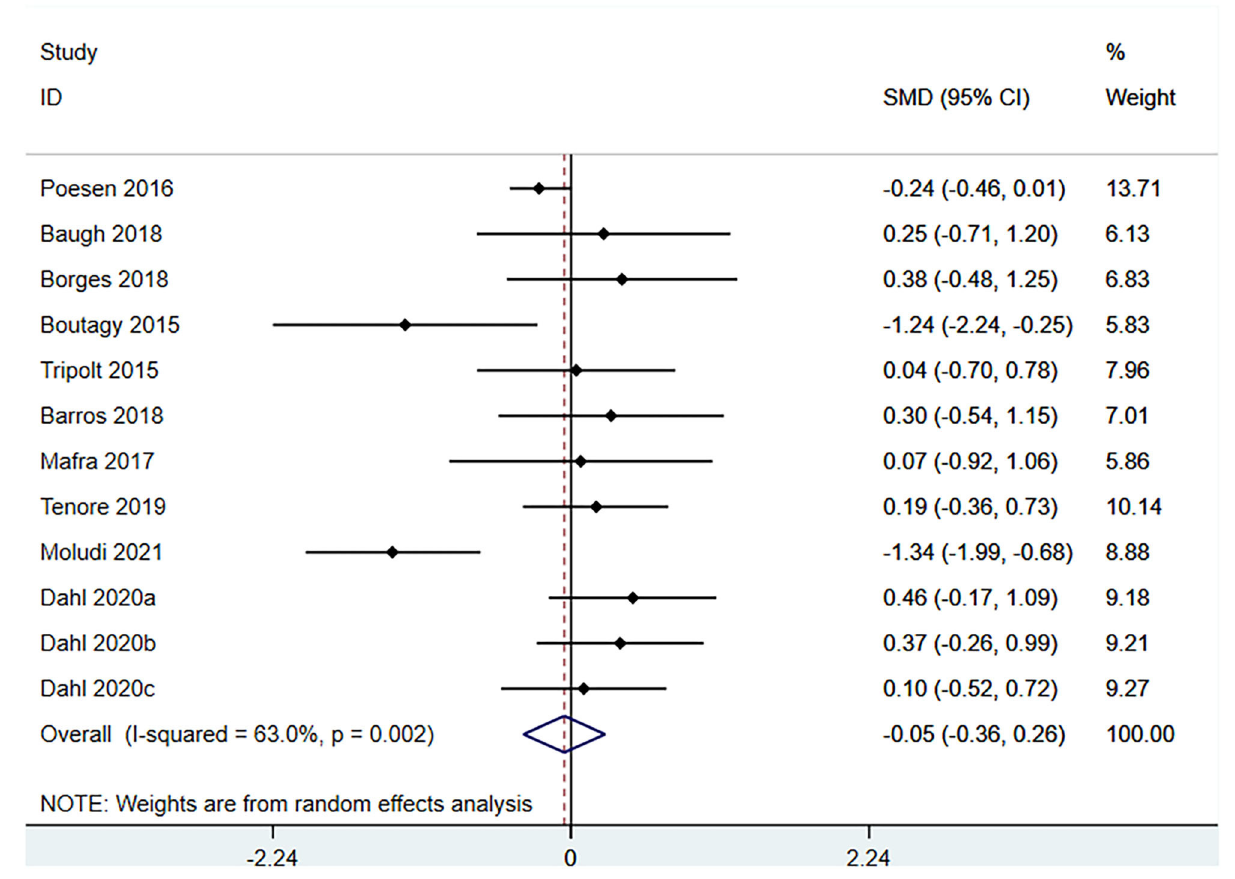
FIGURE 4 | Forest plot for the effect of microbiota-driven therapy on circulating TMAO level. The effect size of each trial or the overall was represented as black diamond and the weight of each trail in the overall study was represented as gray box around black diamond. The estimated 95% confidence interval of effect size was identified by extending lines. CI, confidence interval; RCT, randomized controlled trial; SMD, Standard Mean